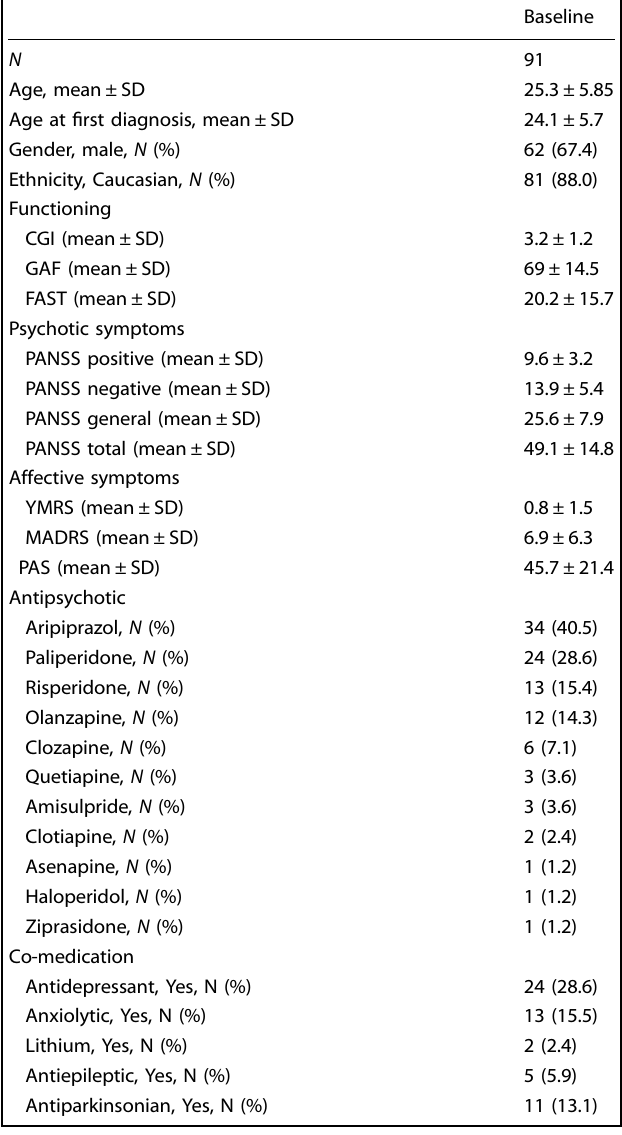
Table 1. Demographic, clinical and pharmacological data of the 91 participants in the present